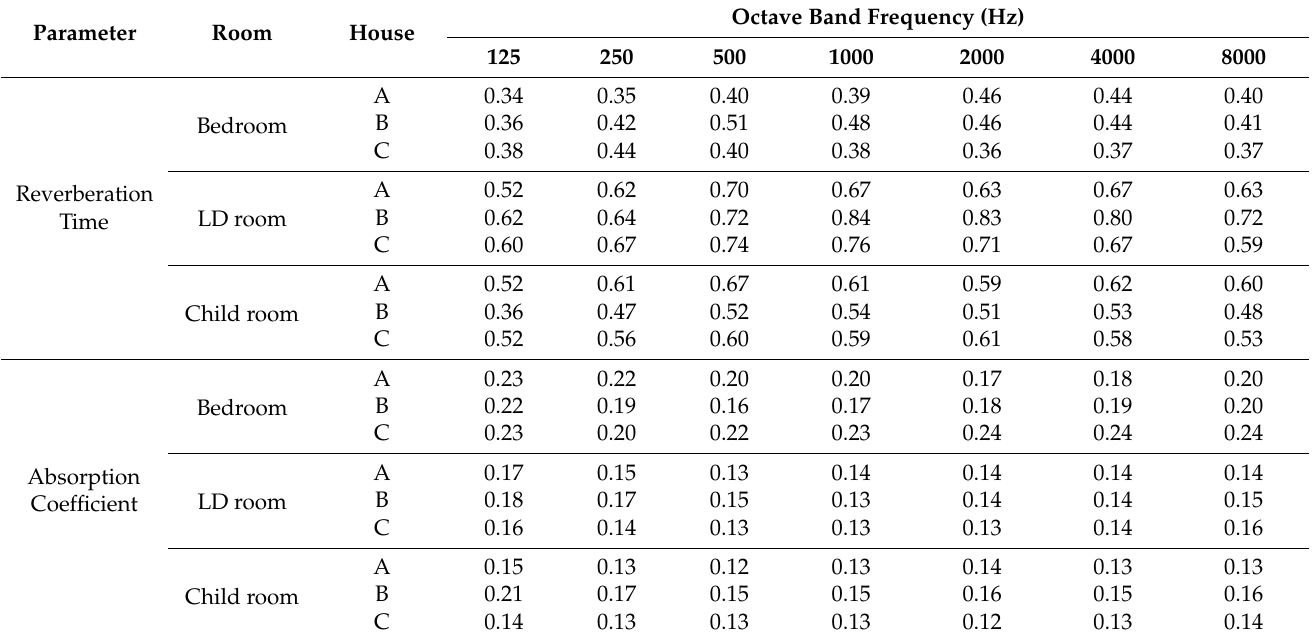
Table 7. Reverberation times and absorption coefficients in the nine